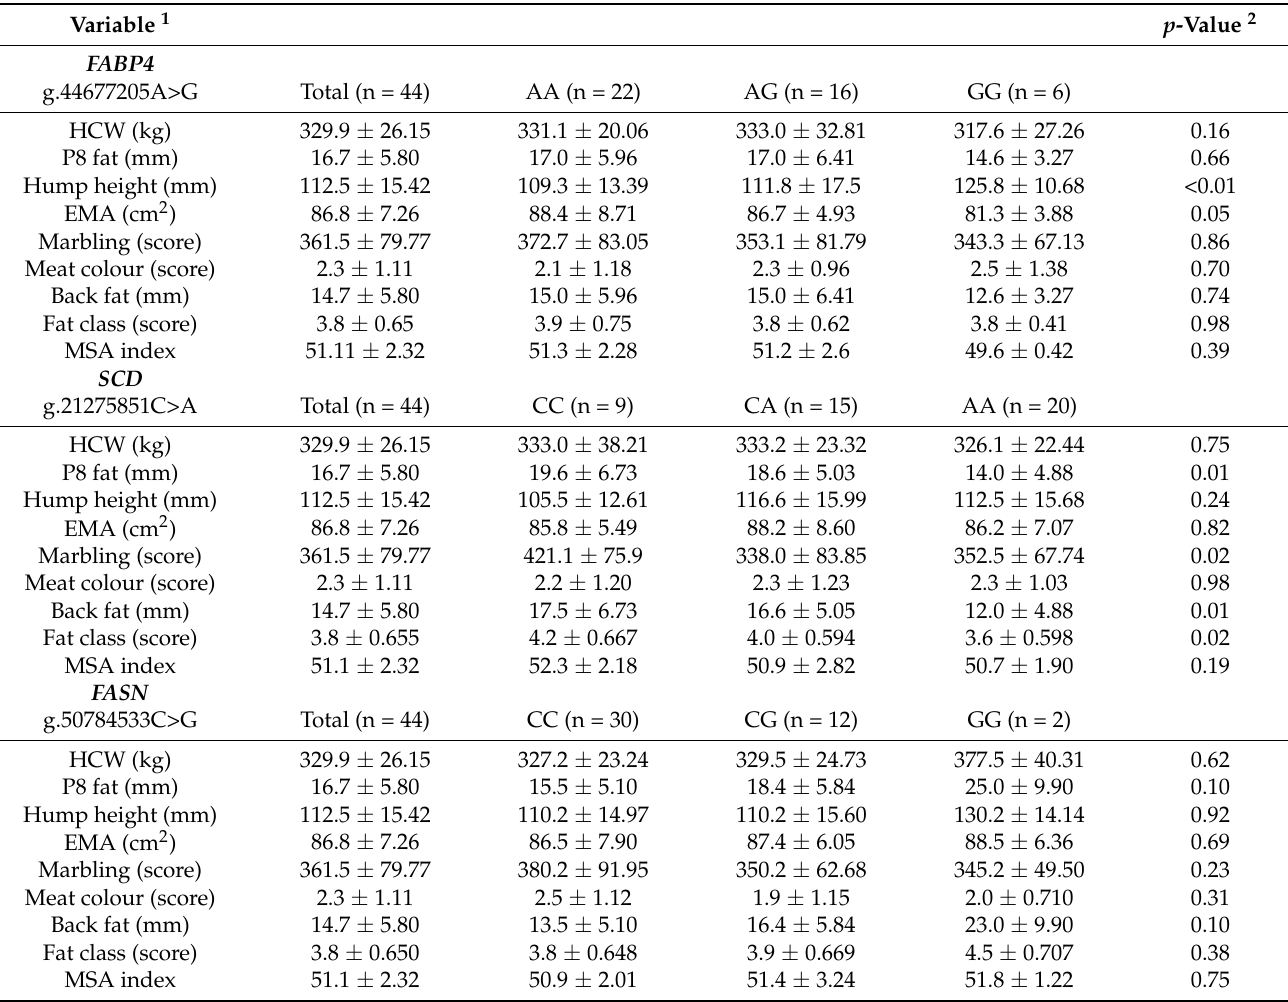
(Figure 4; p ≤ 0.03), but genotypic differences between AA and AG were not significant ( p = 0.81). The AA genotype of SCD g.21275851C>A SNP had the lowest P8 fat, marbling, backfat, and fat class, while the highest scores were observed for the CC genotype ( p < 0.02). Multiple comparisons between SCD g.21275851C>A SNP variants and carcass traits indi- cated that P8 fat, marbling, backfat, and fat class scores were significantly different between the CC and AA genotypes (Figure 5; p < 0.03). No significant associations were observed between the FASN g.50784533C>G variants and the carcass traits measured ( p ≥ 0.10). Table 3. Least square means ± SD of carcass traits due to SNP in FABP4 g.44677205A>G, SCD g.21275851C>A, and FASN g.50784533C>G in northern Australian tropical crossbred beef